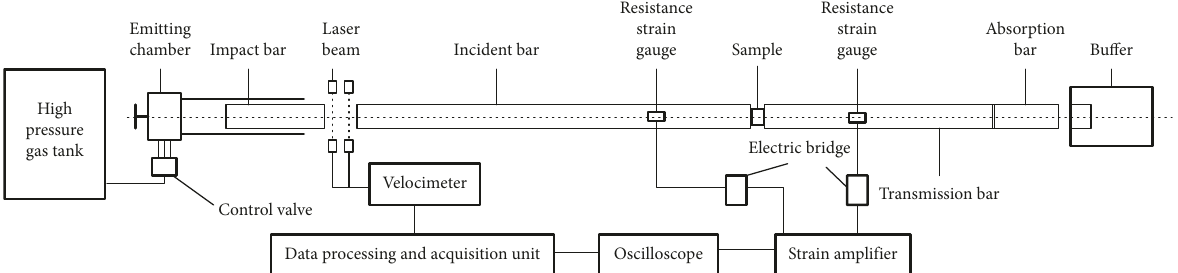
Figure 2: Components of SHPB testing system.